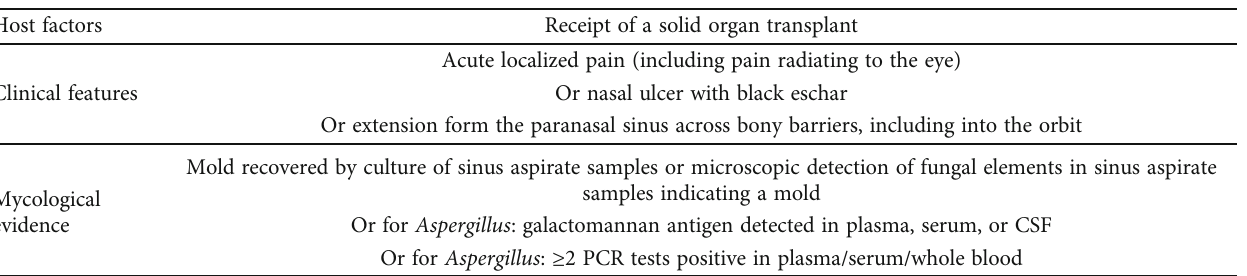
Table 1: Host factors, clinical, and mycological criteria for the diagnosis of probable sino-orbital fungal infection in solid organ transplant recipient (adapted from 11